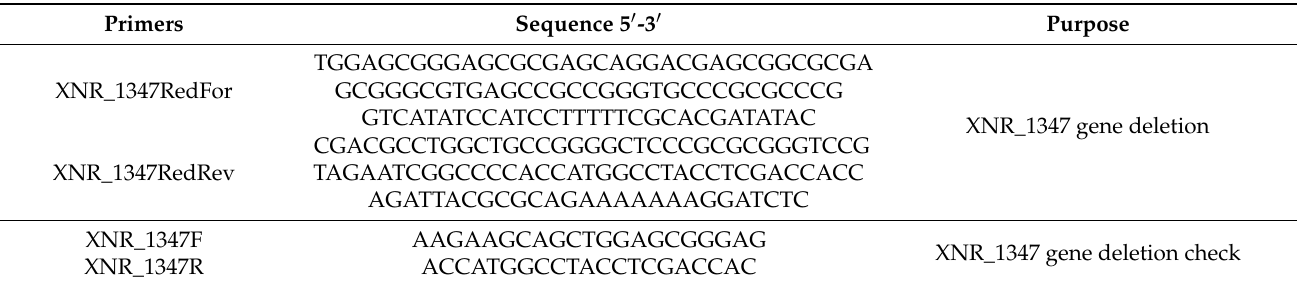
Table 2. Primers used in this